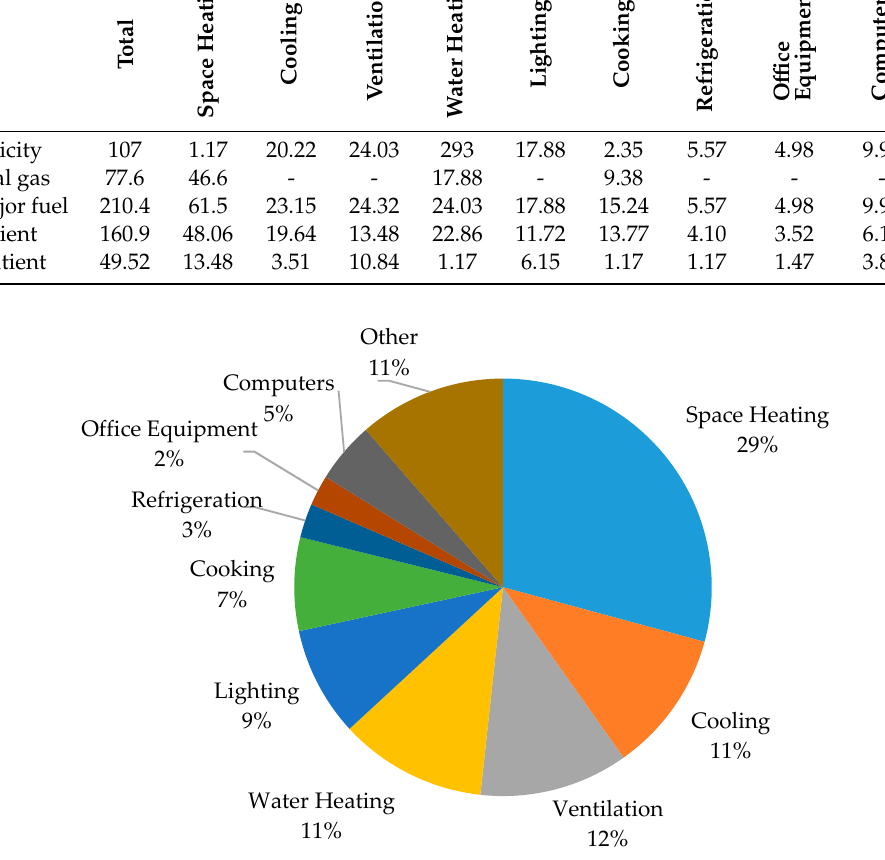
Figure 2. Major fuel consumption breakdown by end-use .